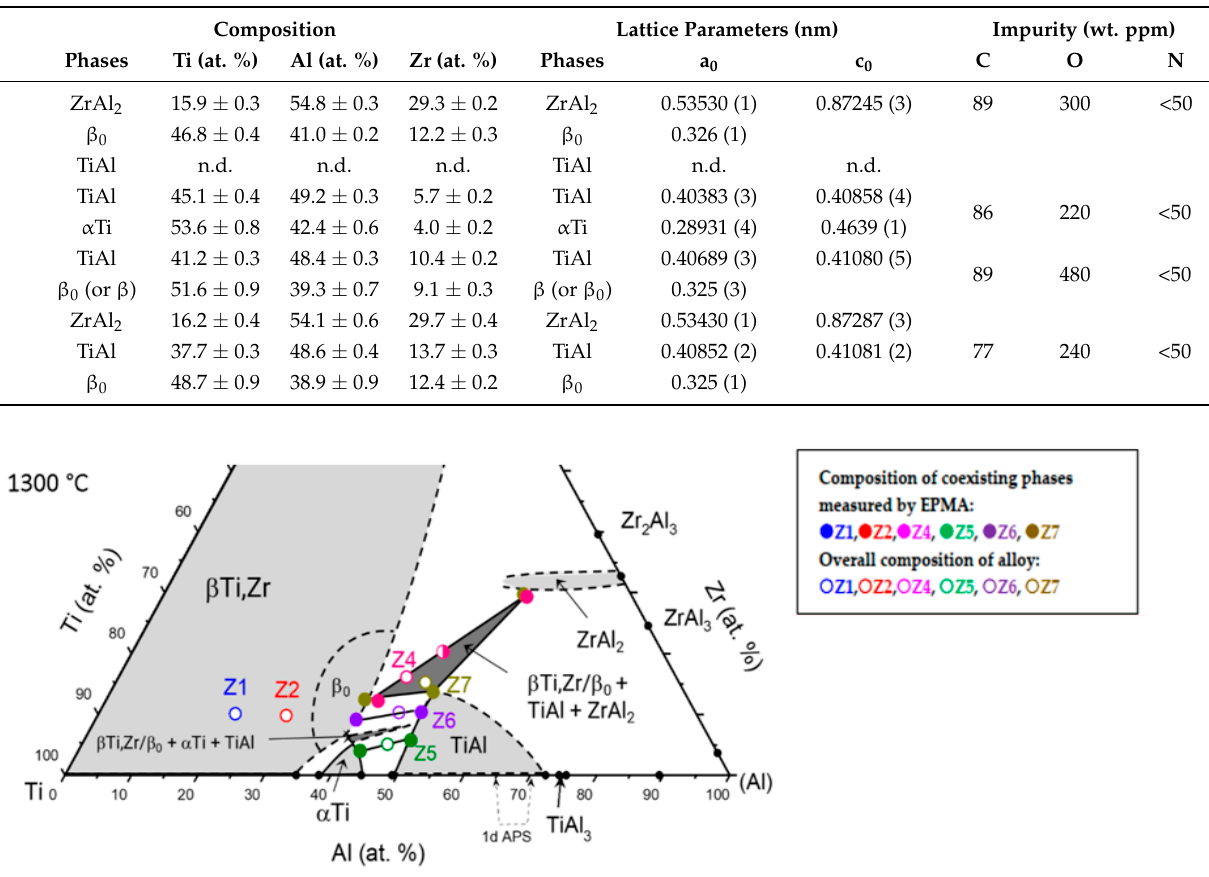
Figure 9. The partial Ti—Al—Zr isothermal section at 1300 °C.